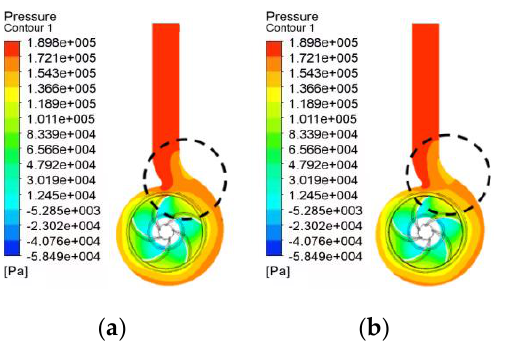
Figure 9. Pressure contours of flow region at 1000 rpm. ( a ) Original model; ( b ) rounded model.